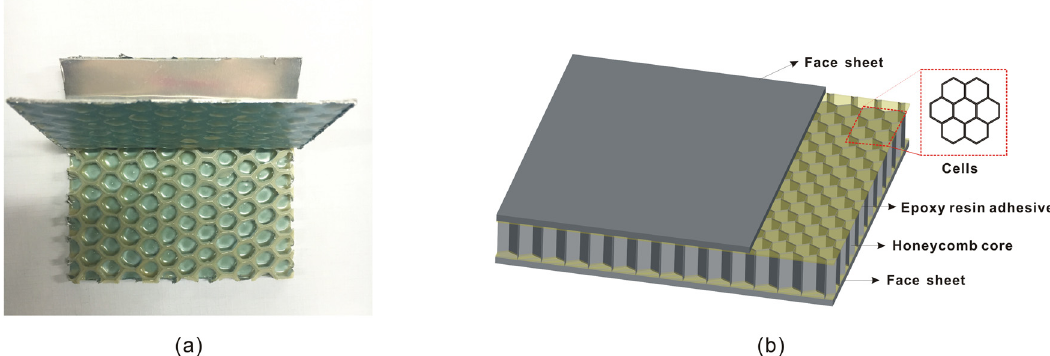
Figure 1: ( a ) Image of honeycomb sandwich plate and ( b ) schematic diagram of